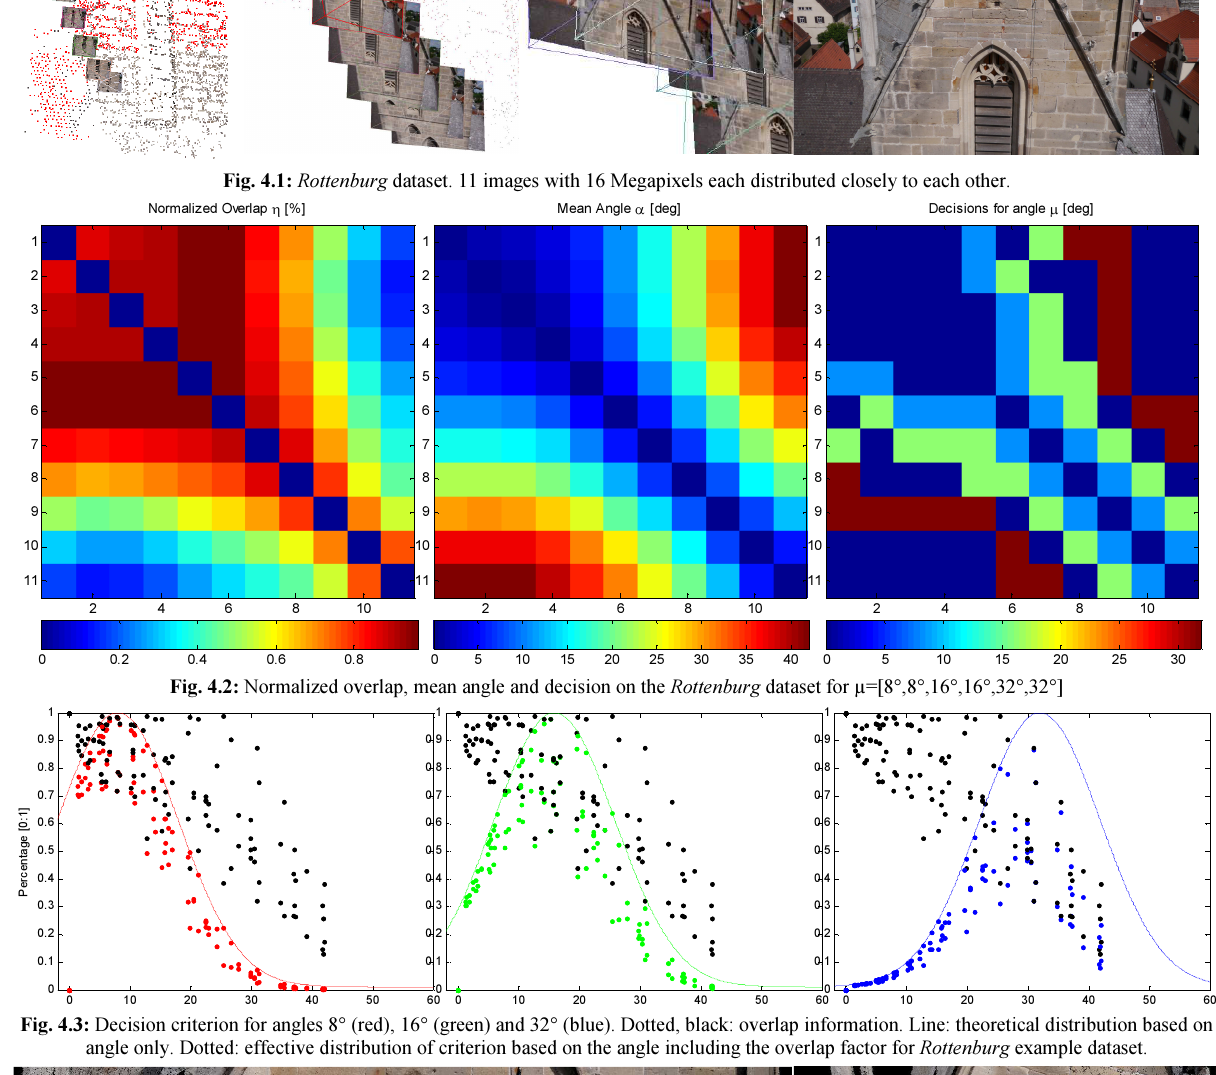
Fig. 4.2: Normalized overlap, mean angle and decision on the Rottenburg dataset for µ=[8°,8°,16°,16°,32°,32°]